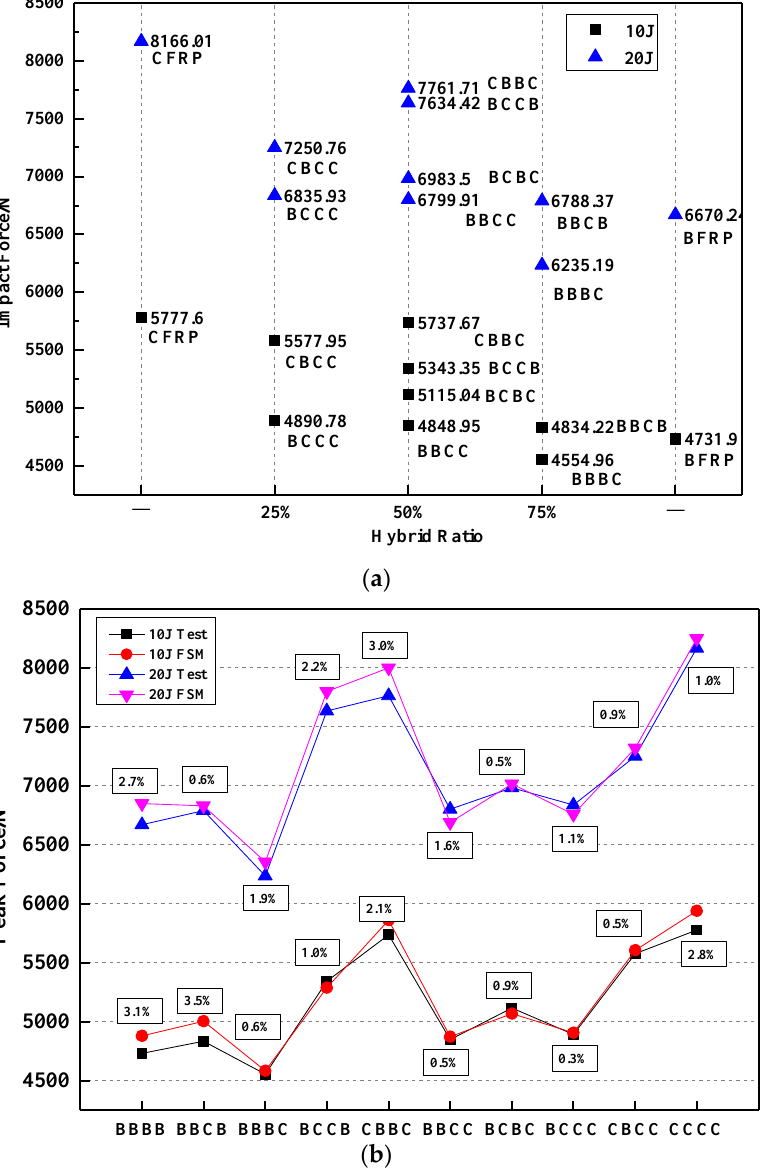
Figure 5. Peak force of ( a ) different hybrid ratio and ( b ) trend curve and comparison diagram of FEM and test.